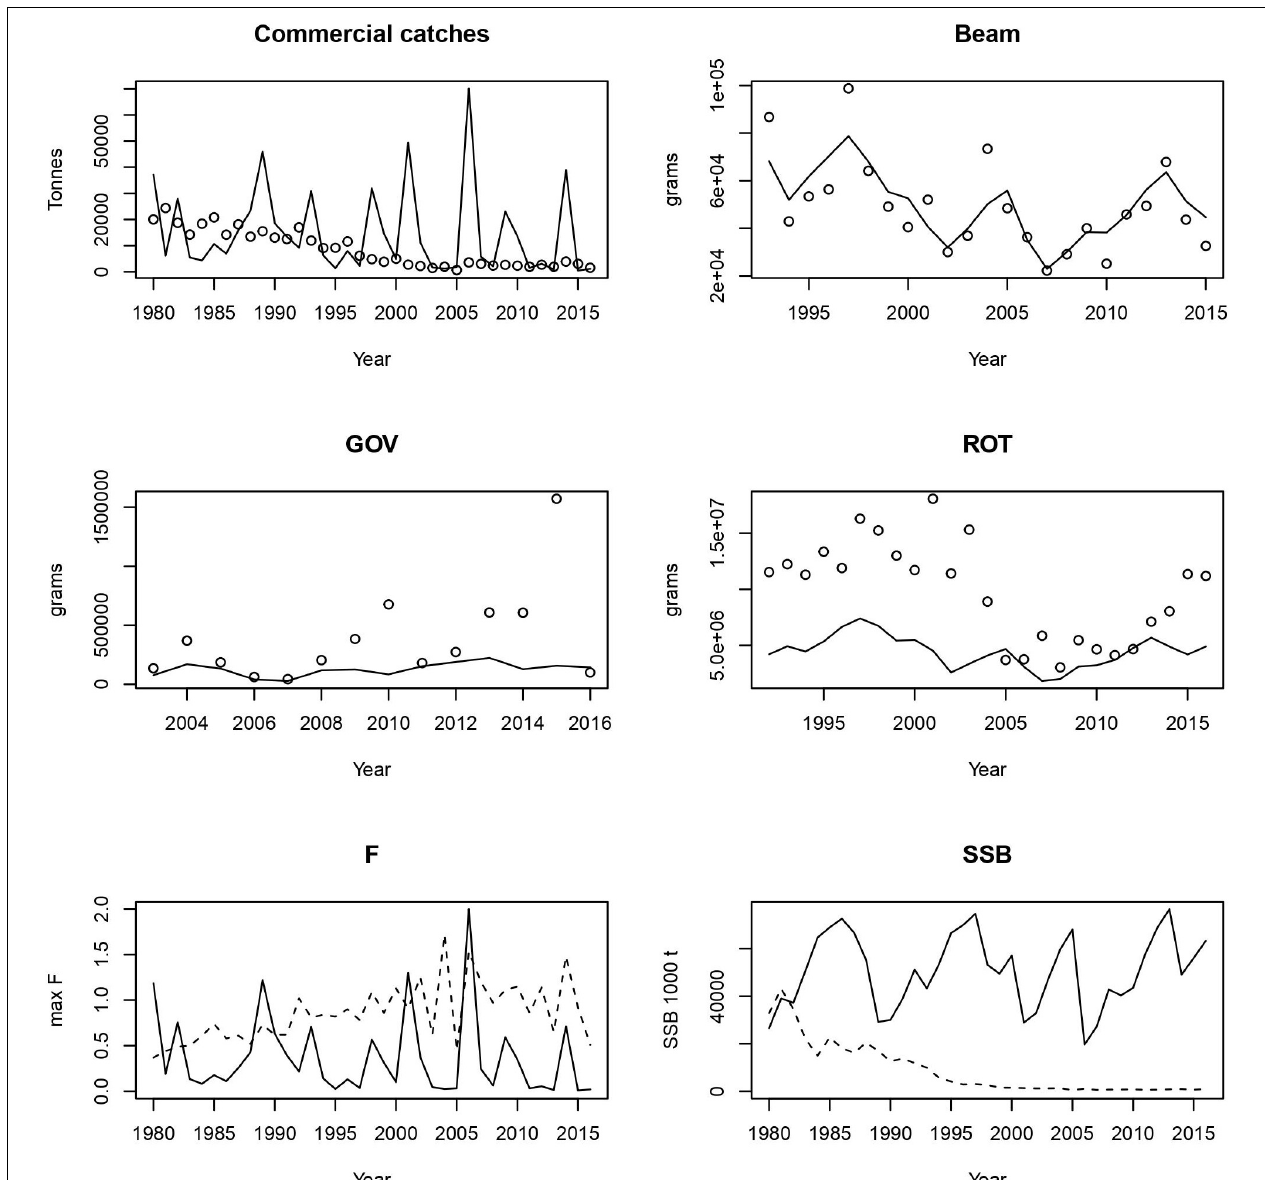
FIGURE 3 | Fits to commercial catches and the three surveys (top 4 panels) and comparison of estimates of F and SSB with single species assessments for whiting. In each case the model is the solid line.